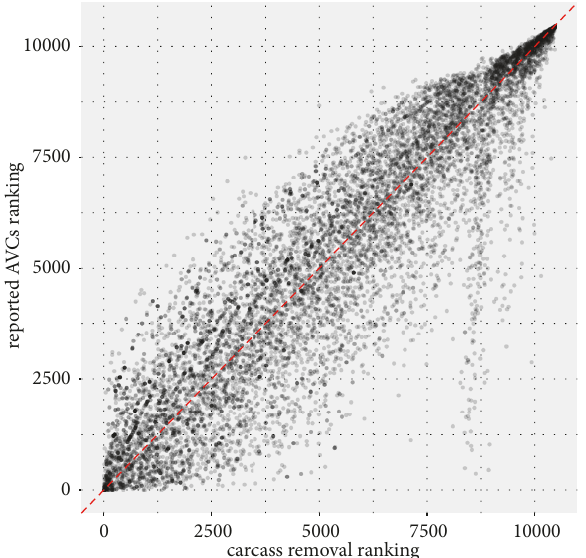
Figure 5: Comparison in HSID ranking by the carcass removal and the reported AVC using GNB